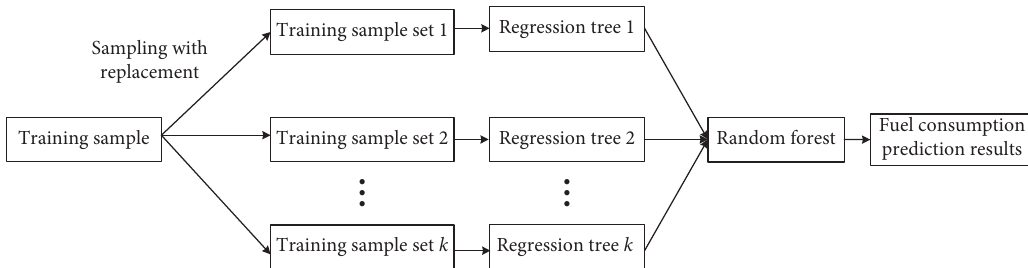
Figure 4: The structure of vehicle fuel consumption prediction model based on the random forest.